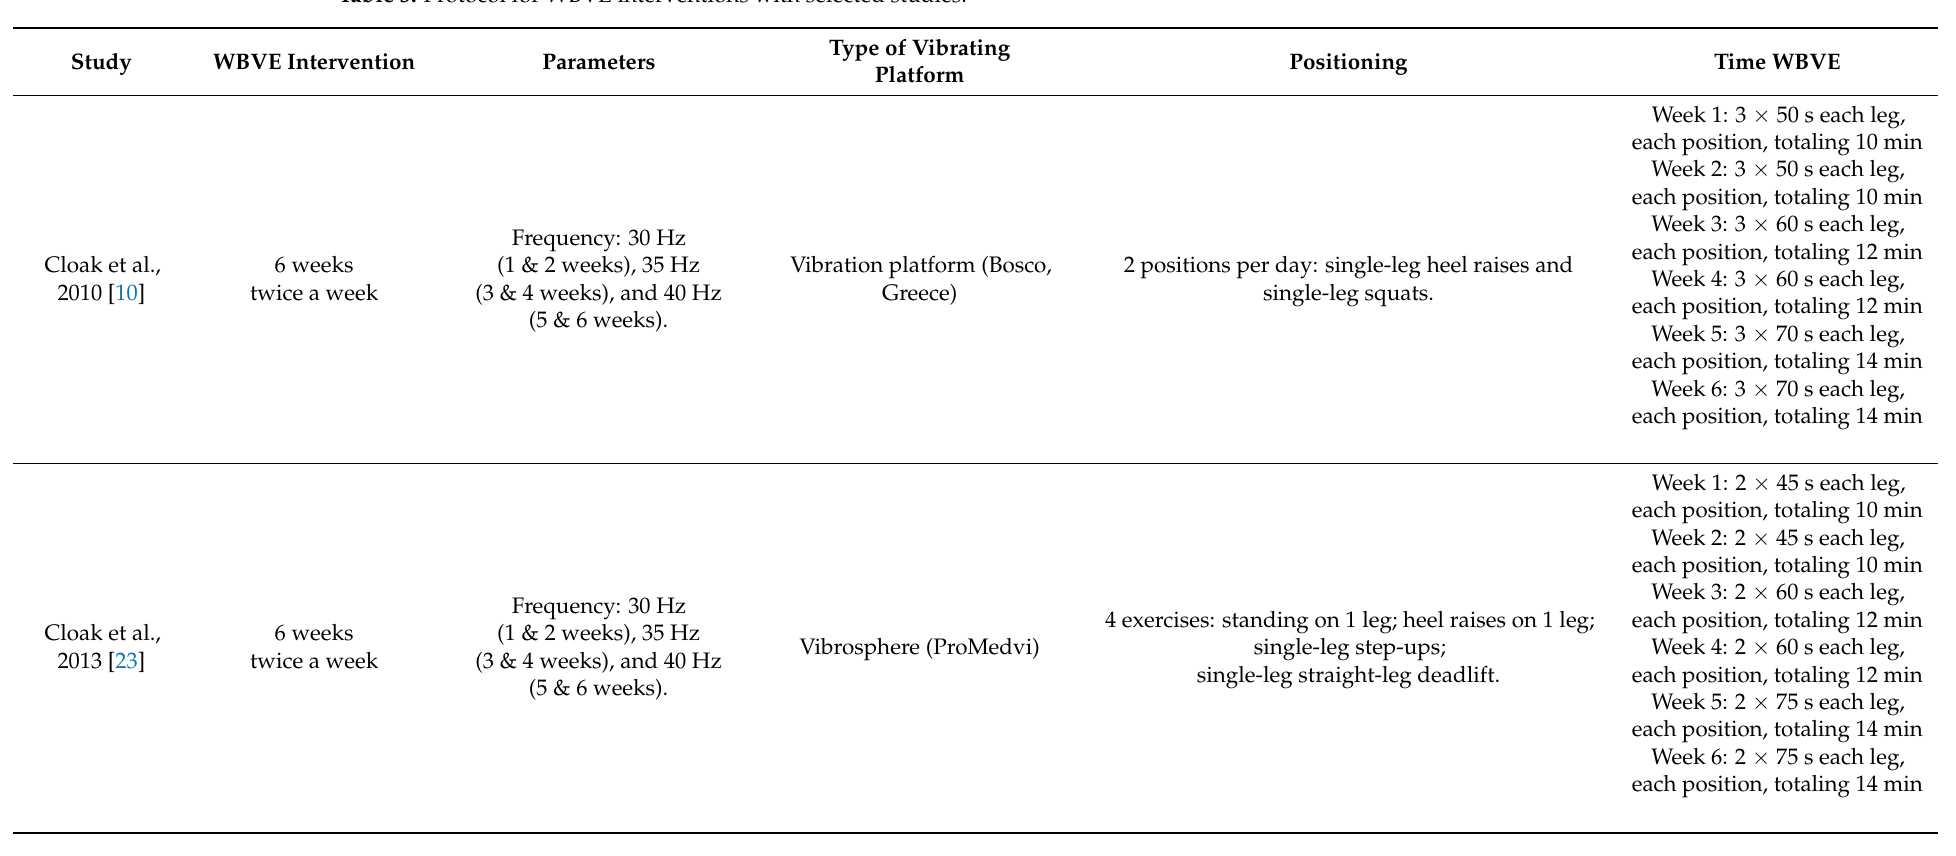
Table 3. Protocol for WBVE interventions with selected